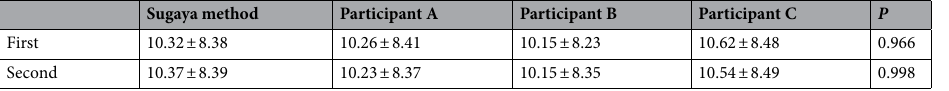
Table 1. Percentage of glenoid bone defect measured by the Sugaya method and the comparison card method (n = 33), %, mean ± standard.